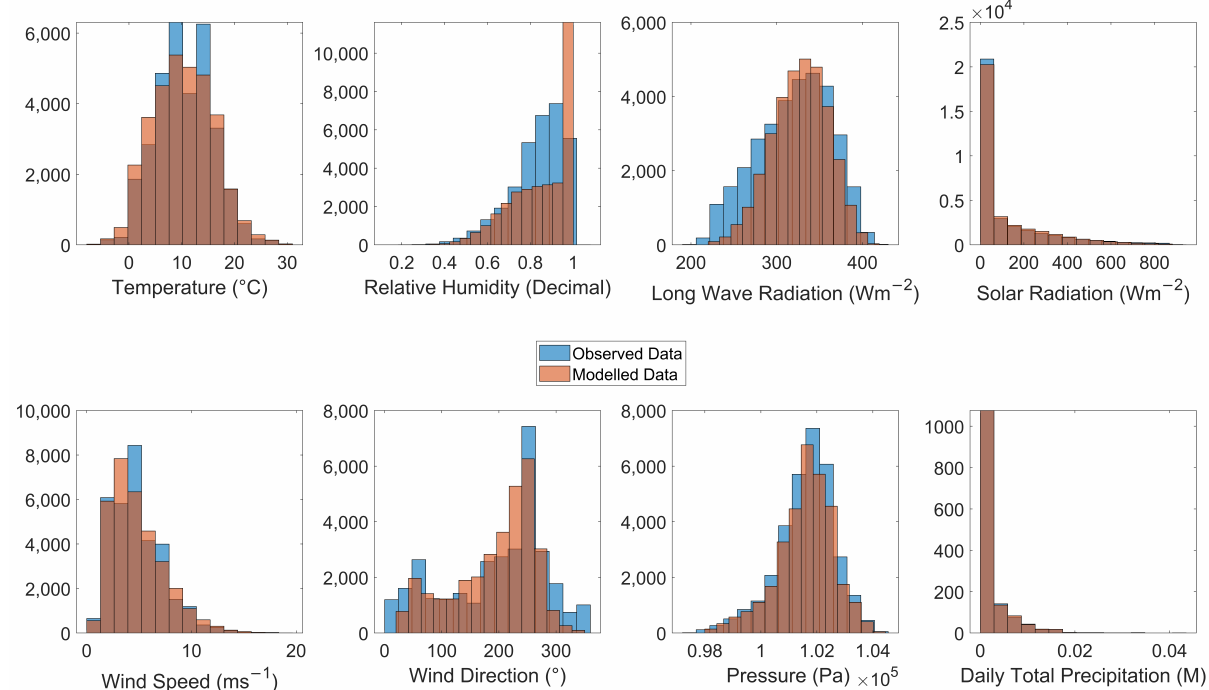
Figure 3. Frequency plots of the eight meteorological elements (temperature, relative humidity, long wave and solar radiation, wind speed and direction, atmospheric pressure and precipitation) used in the model comparing the observed meteorological factors with the corresponding down-scaled